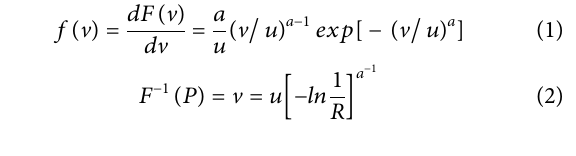
Frontiers in Built Environment |